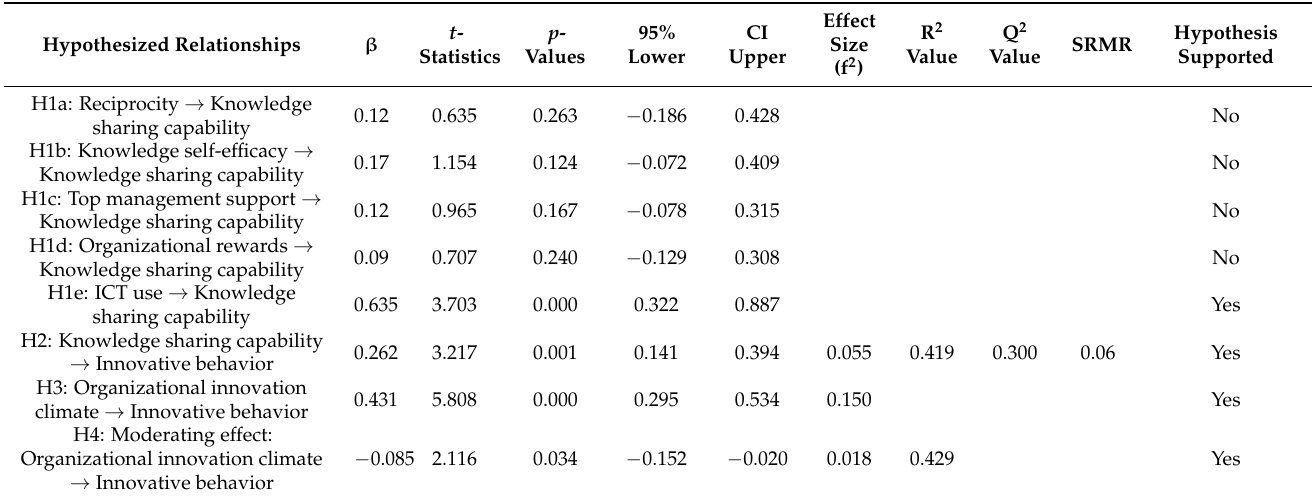
Table 4. Findings from the PLS-SEM analysis.